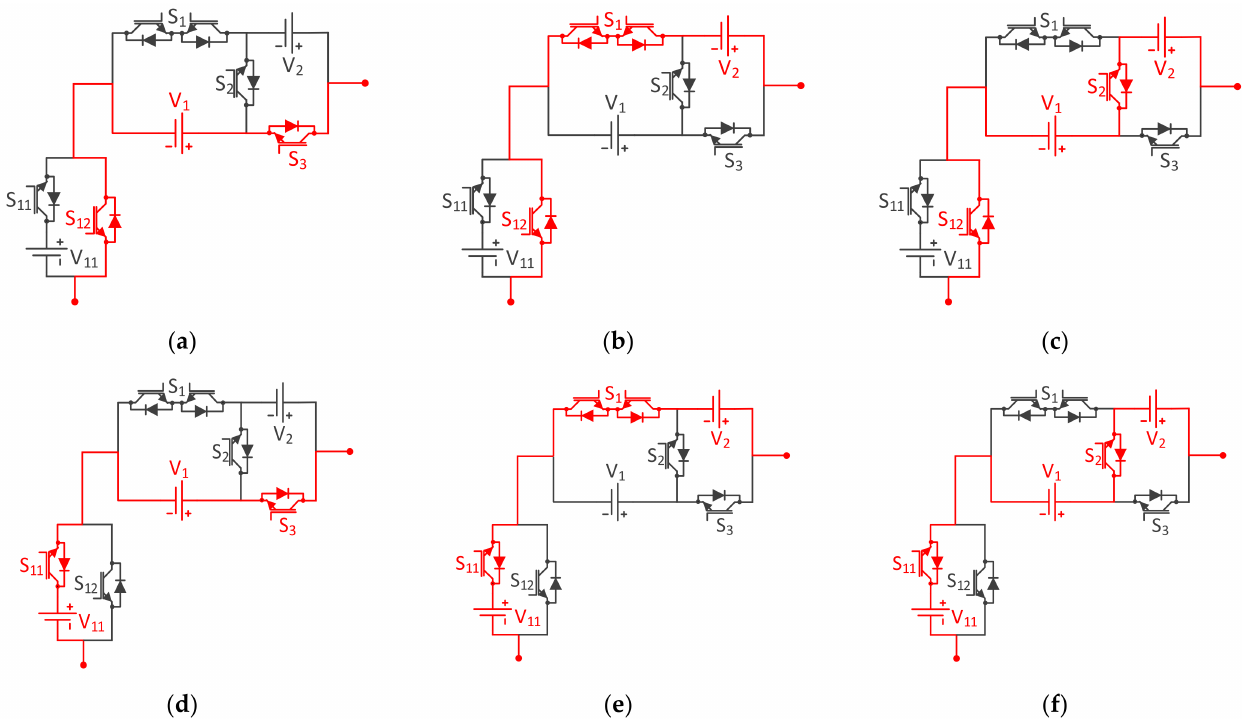
Figure 2. Different switching states of level generation unit ( a ) V o = V 1 , ( b ) V o = V 2 , ( c ) V o = V 1 + V 2 , ( d ) V o = V 11 + V 1 , ( e ) Vo = V 11 + V 2 , and ( f ) V o = V 11 + V 1 + V 2